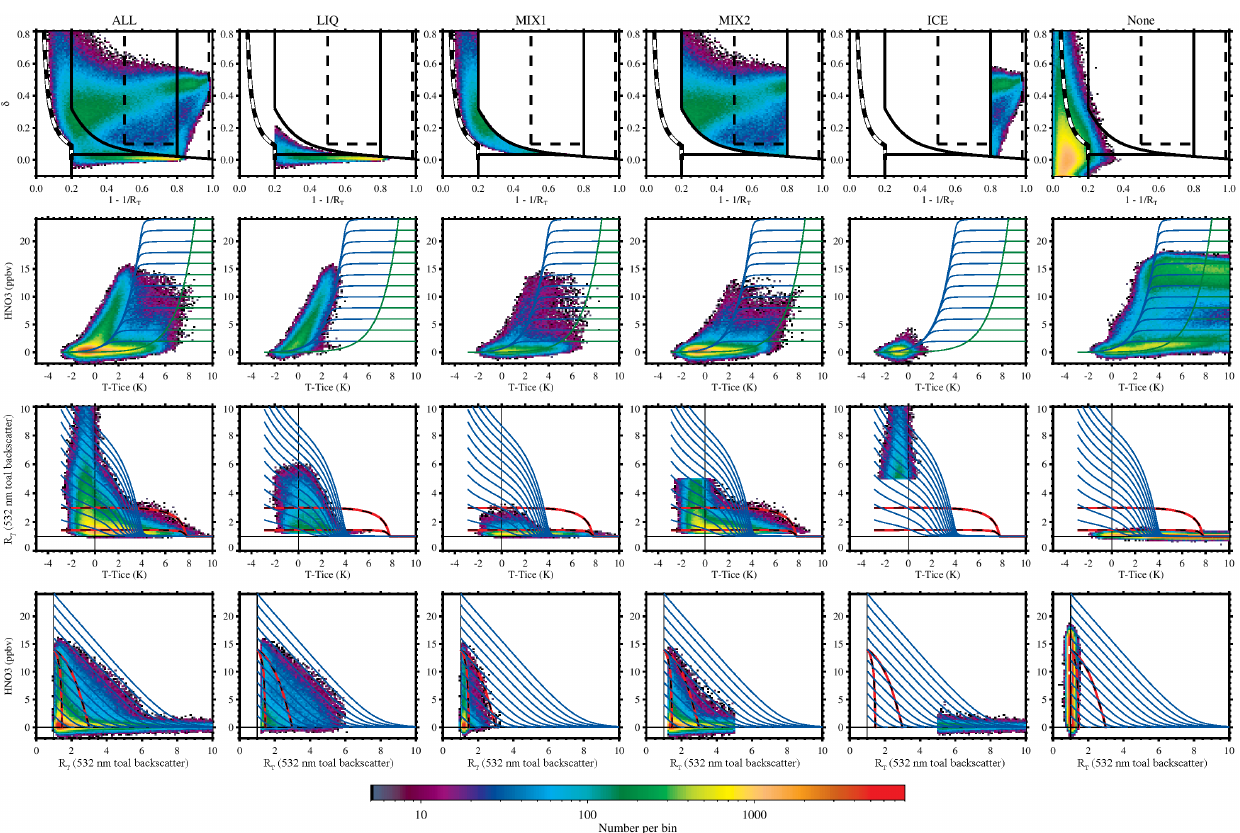
Figure 7. CALIOP PSC type classifications and their corresponding 2-D cross-section pairs derived from the 3-D coordinate space of temperature T − T ICE , HNO 3 , and total backscatter, R T , for 10 May to 25 October 2009. The six columns are the CALIOP PSC types identified in the text. Blue (green) lines are theoretical calculations for total HNO 3 from 2 to 24ppbv in 2ppbv steps for STS (NAT) equilibrium. Red–black dashed lines are theoretical calculations for equilibrium NAT with number densities 0.001cm − 3 (bottom curve) and 0.01cm − 3 (top curve) and 14ppbv total HNO 3 . The lower limit of detection, given by the black–white dashed line, is described in the